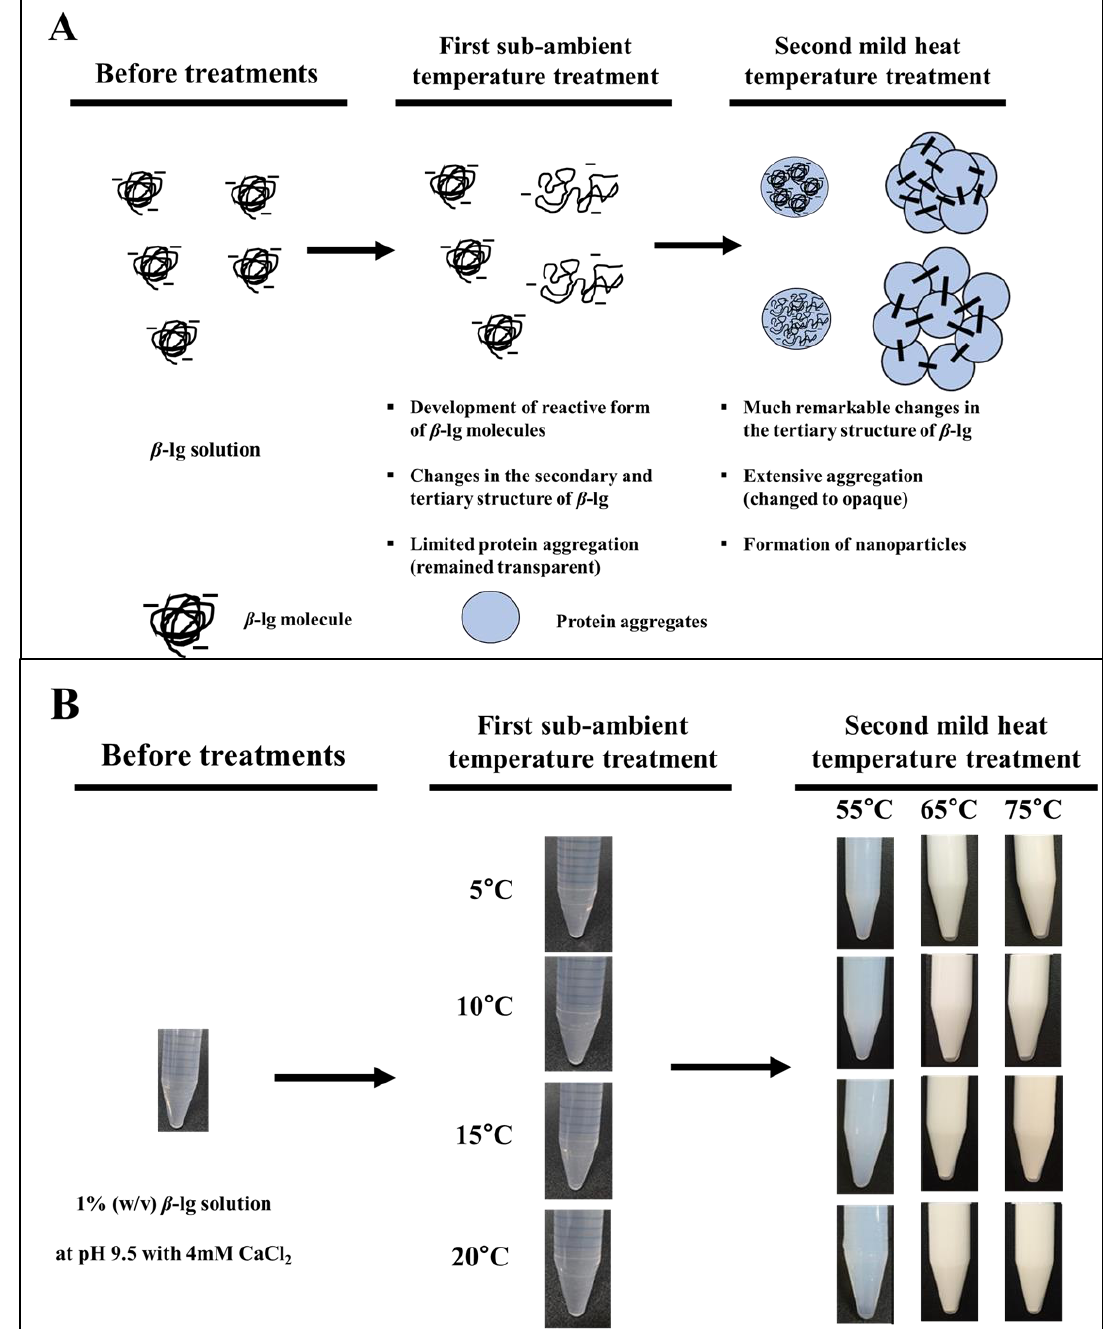
Figure 5. Overall schemes of the two-step temperature process used to produce β -lg nano-delivery systems (NDSs). ( A ) Structural changes of β -lg molecules during NDS formation by the use of the two-step temperature process; ( B ) changes in the turbidity of β -lg solution during NDSs formation by the use of the two-step temperature process. This figure was adapted, with permission, from Ha et al. [25].